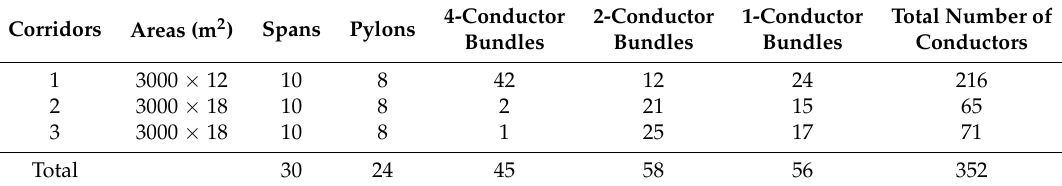
Table 2. Summary of Bindebango (BDB) data set.